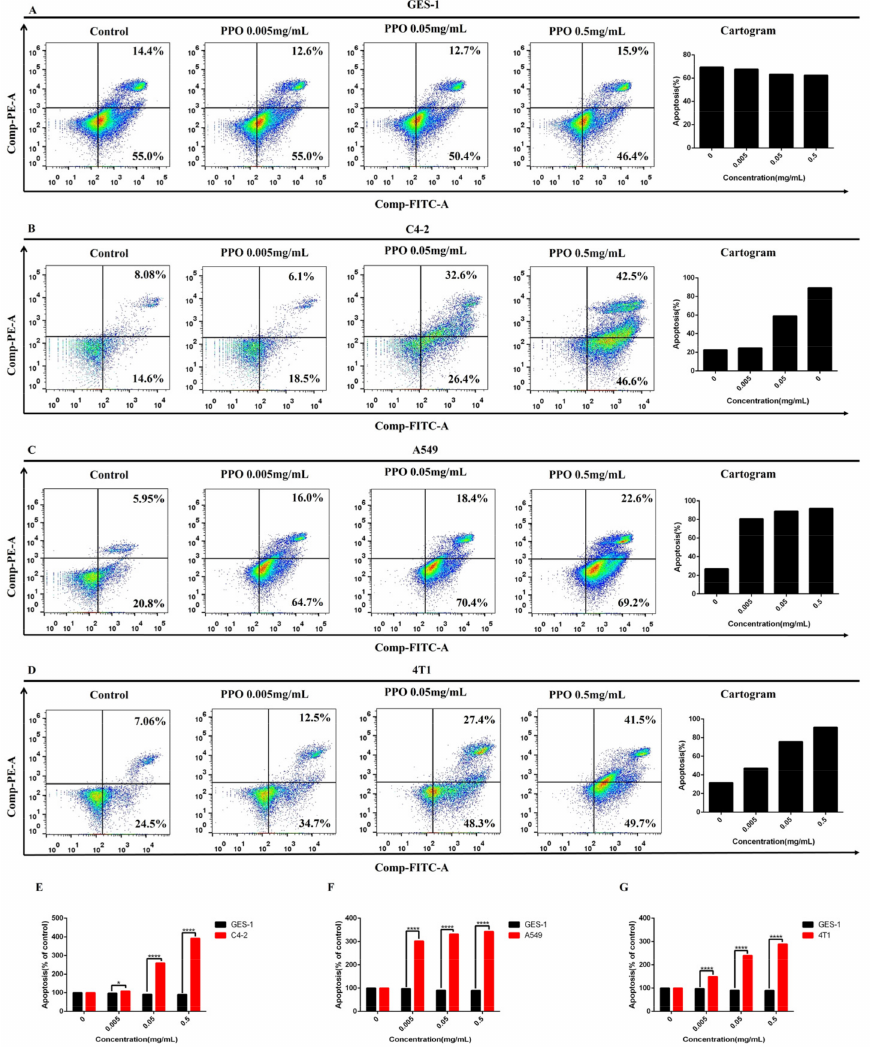
Figure 4. Effect of PPO on the apoptosis of ( A ) human gastric normal cell GES-1, ( B ) prostate cancer cell C4-2, ( C ) lung cancer cell A549, ( D ) breast cancer cell 4T1. Comparison of the effects of PPO on the apoptosis of ( E ) prostate cancer cell C-2, ( F ) lung cancer cell A549, ( G ) breast cancer cell 4T1 and human gastric normal cell GES-1; bars, SE (* p < 0.05; **** p < 0.0001 versus